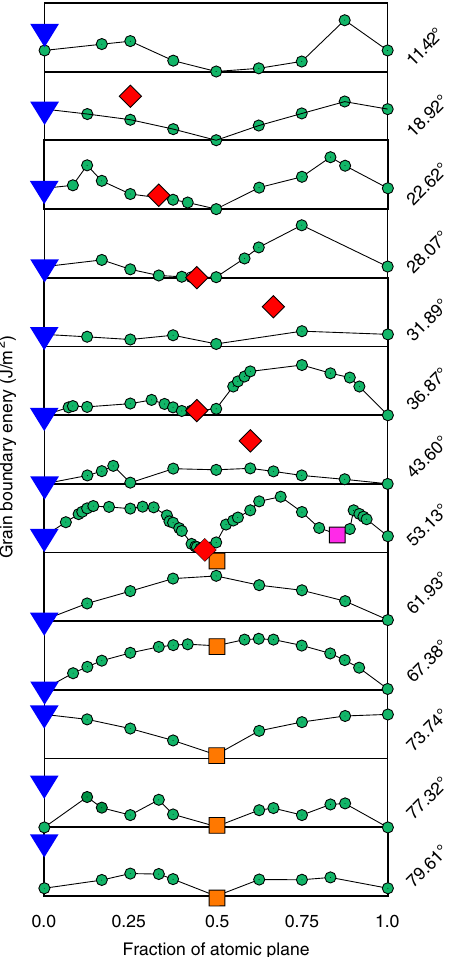
Fraction of atomic plane Fig. 3 Energy map of GB phases. Evolutionary search and clustering identify new ground states and multiple grain boundary phases. The search explores different atomic densities and fi nds low-energy grain boundary con fi gurations (green circles) ignored by the conventional methodology. For each grain boundary (angle θ ) atomic fractions and energies of different grain boundary phases at 0 K are indicated by blue triangles (Kite family), red diamonds (Split Kite family) and orange squares (Extended Kite